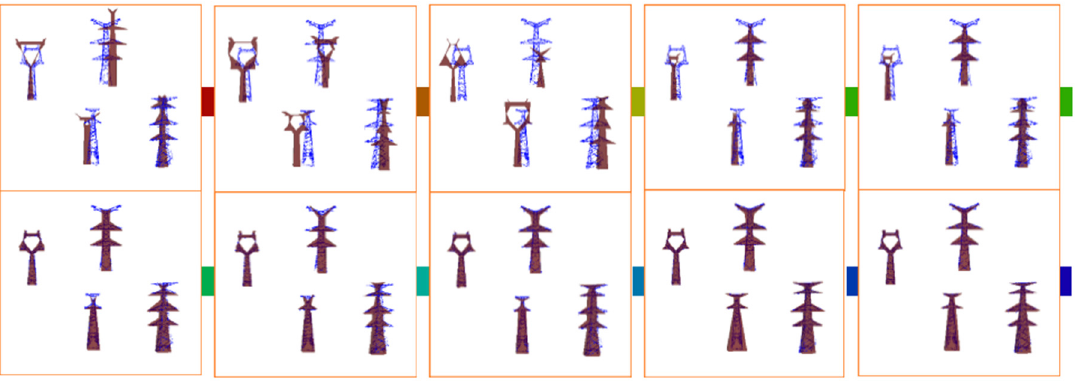
Remote Sens. 2016 , 8 , 243